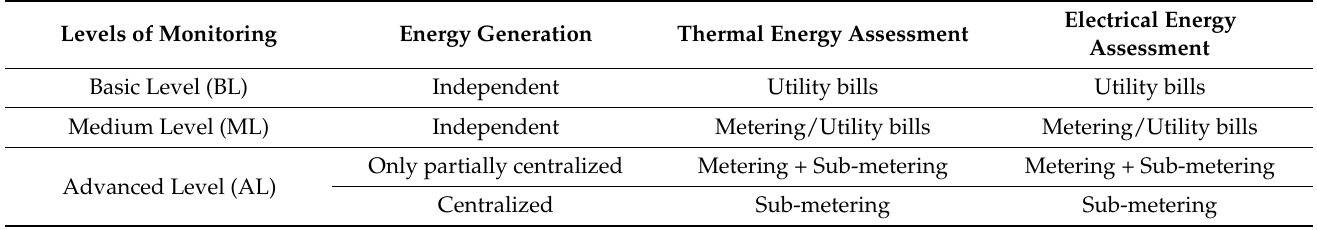
Table 1. Levels of monitoring, according to the assessment method of each building